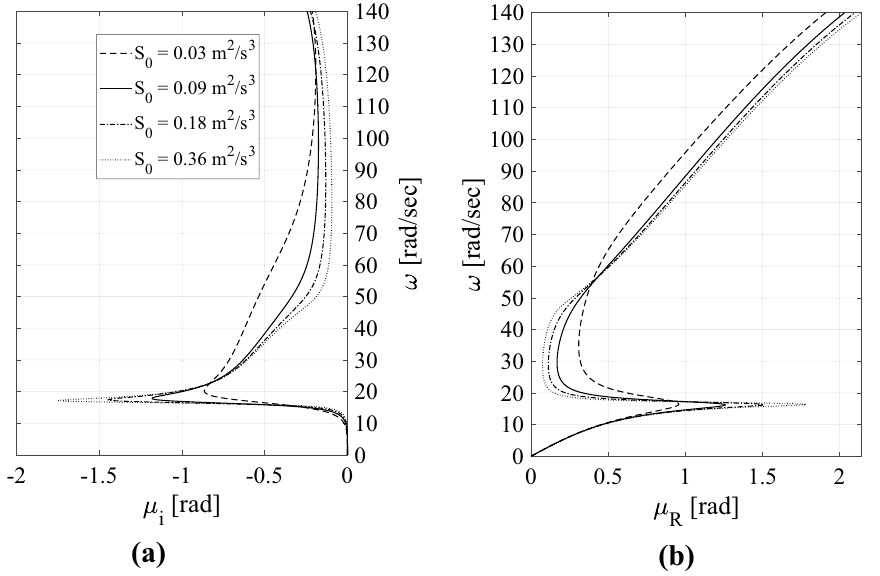
Figure 12. Periodic metafoundation dispersion curves: ( a ) imaginary component of μ ; ( b ) real component of μ